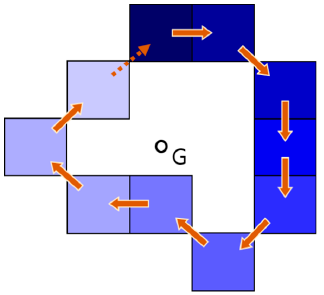
Figure 8. The case of circular path.